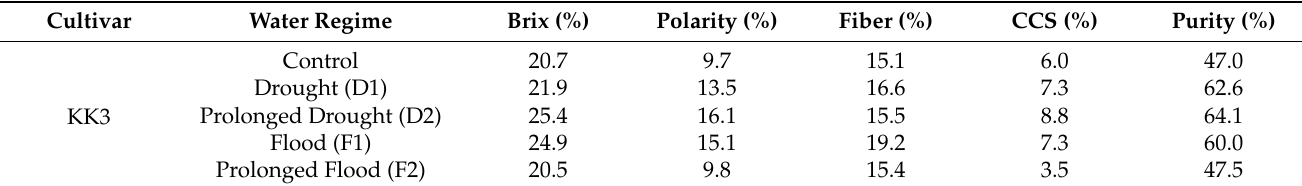
Table 6. Sugar quality of two sugarcane cultivars at harvest as affected by drought, flood, and combined treatments, Experiment 1.